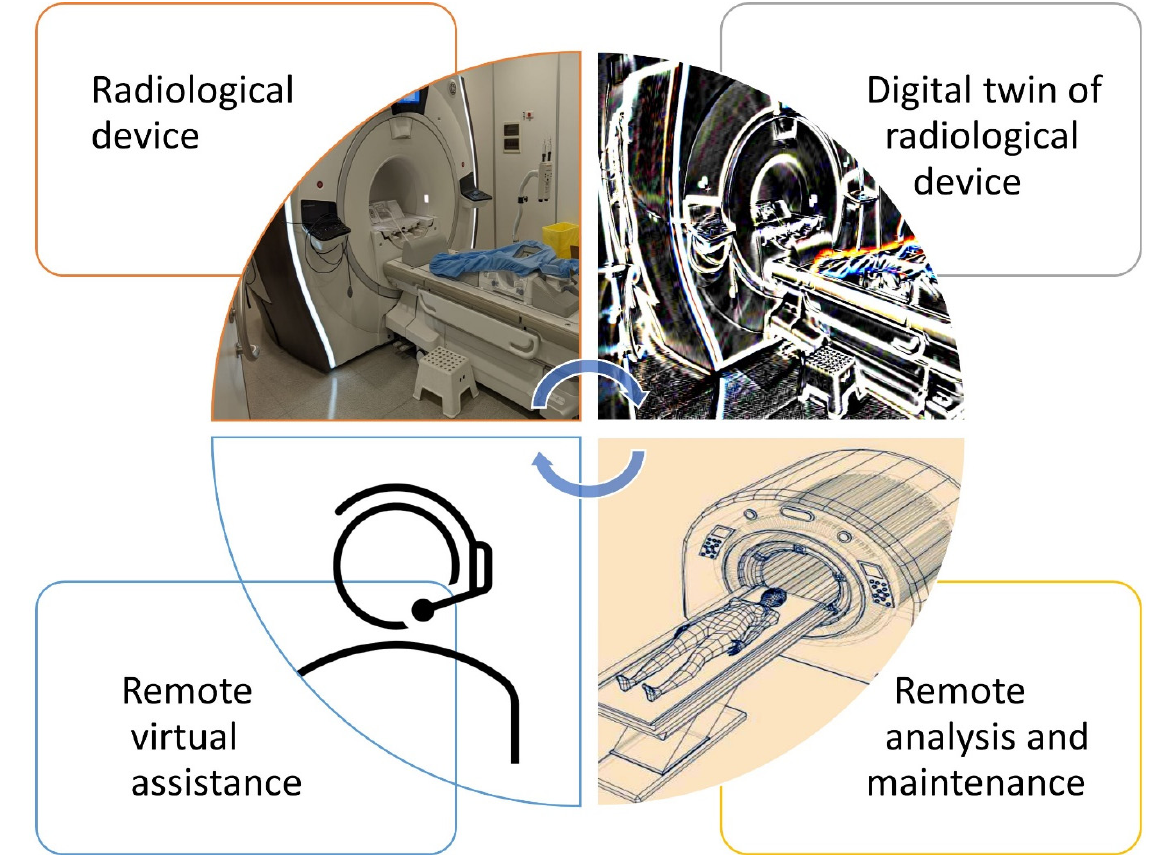
Figure 1. Key concepts and examples of radiological device digital twin life cycle.